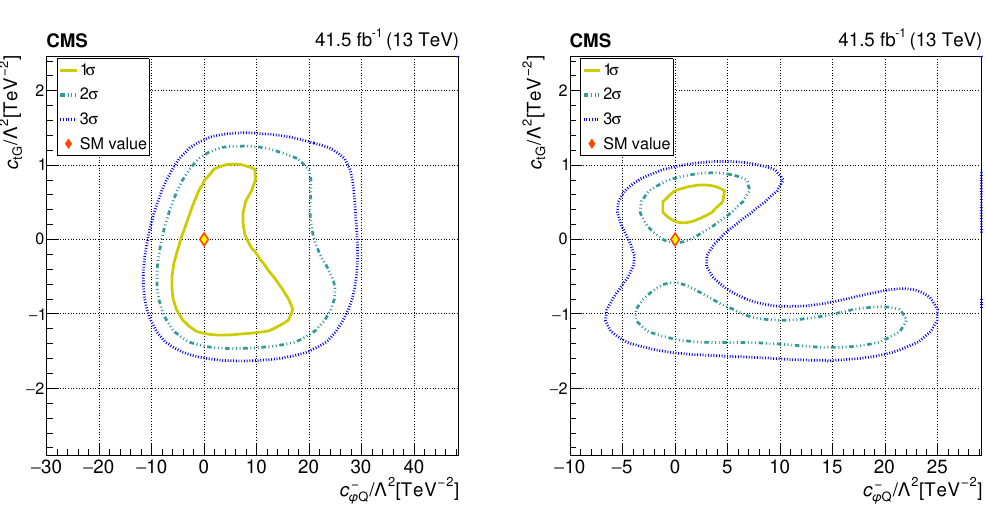
and c − with the t G ϕQ